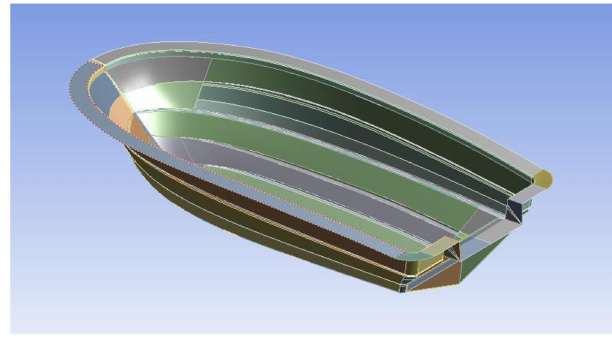
Figure 3. The configuration of hull structure.